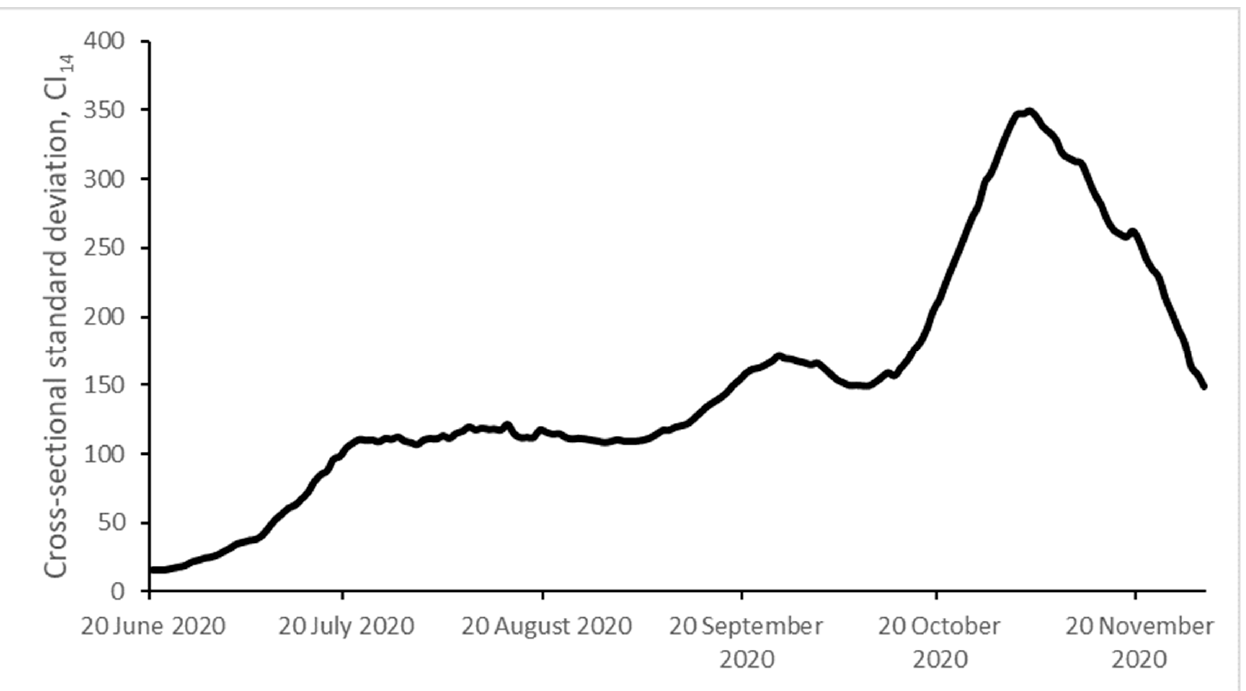
Figure 1. σ -Convergence. Cross-sectional standard deviation.